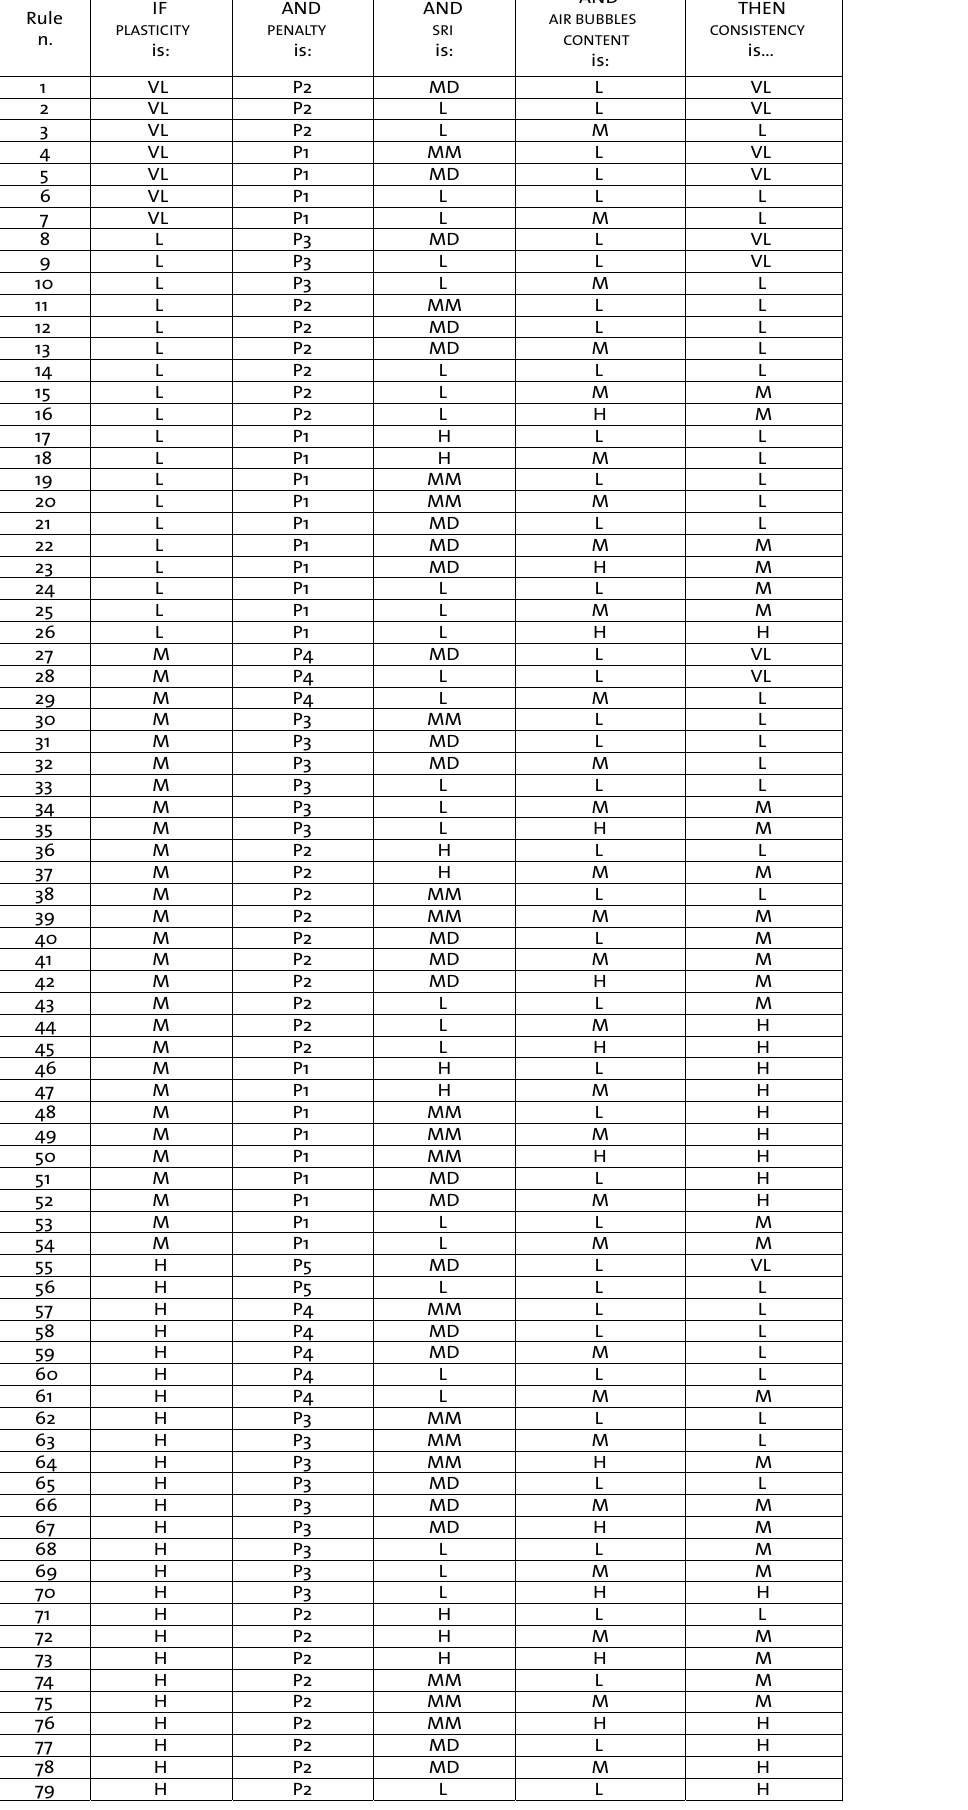
Table 3: Rules of the knowledge base for estimating consistency (VL very low, L low, M medi- um, MD moderate, MM median, H high; see Figs. 5, 7, 8, 9,